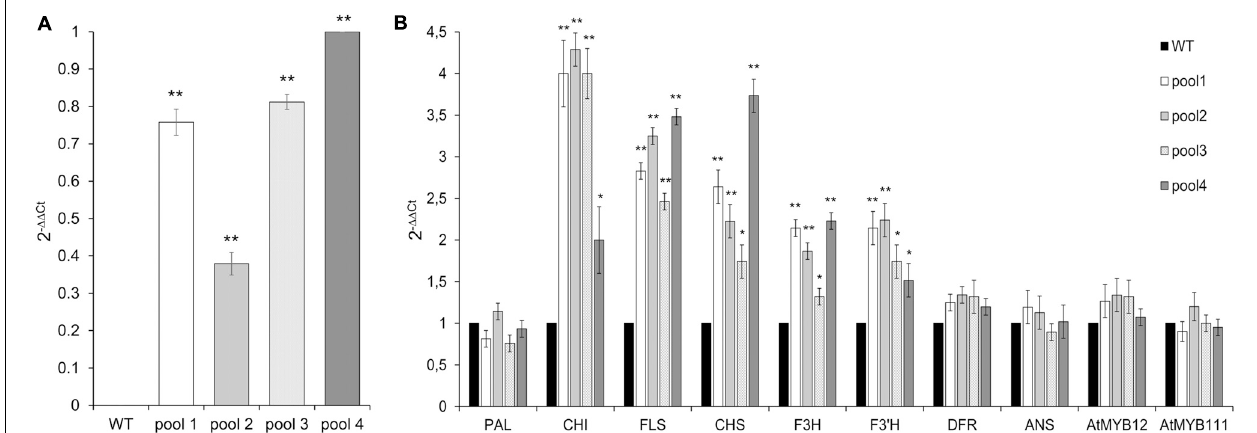
FIGURE 4 | Expression of CcMYB12 transgene (A) and of endogenous phenylpropanoid biosynthetic genes (B) in leaves of transgenic Arabidopsis plants. qRT-PCR experiments were conducted on cDNAs from various transgenic Arabidopsis T3 plants grouped in 4 different pools (pool 1, 2, 3, and 4), each constituted by 4 plants of the same transgenic T3 line. Actin was employed as reference gene. (A) qRT-PCR of CcMYB12 in transgenic Arabidopsis plants. Pool 4 as calibrator. (B) Expression levels of PAL, CHI, FLS, CHS, F3H, F3 (cid:48) H, DFR, ANS , AtMYB12 and AtMYB111 in CcMYB12 transgenic Arabidopsis plants. WT as calibrator. Values are means ± SD of three biological replicates. Asterisks indicate a statistical difference ( ∗ p -value < 0.05; ∗∗ p -value < 0.01) between the means for WT and tested transgenic samples, according to Student’s t -test.